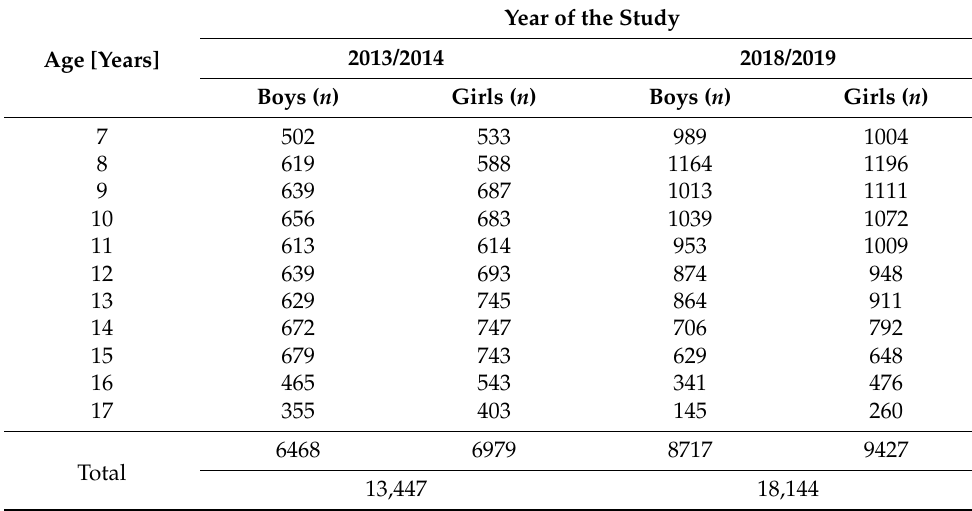
Table 1. Age and sex distribution of children in both studies.